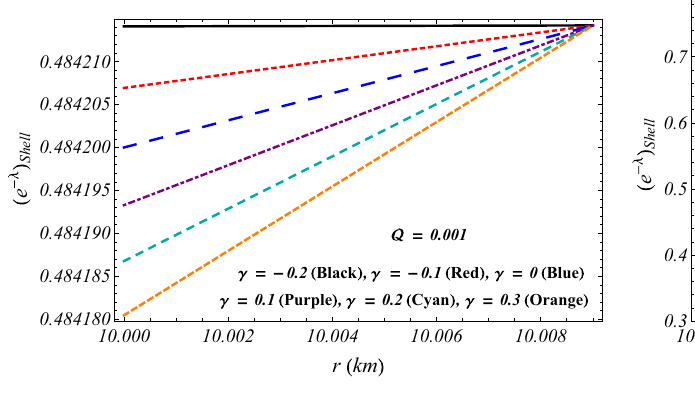
Fig. 2 e − λ inside the thin shell